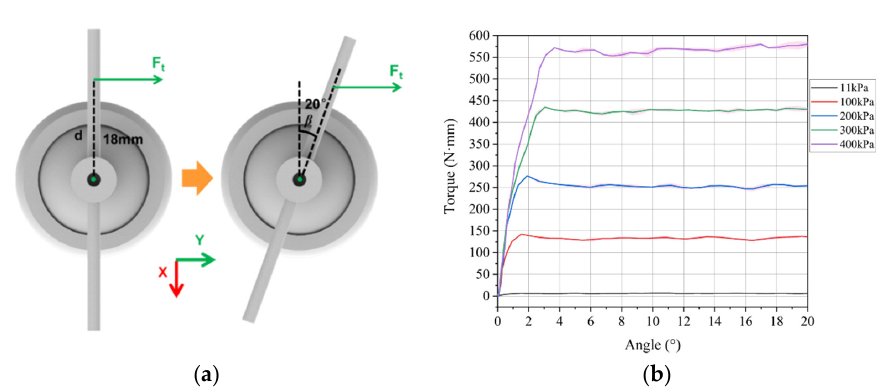
Figure 11. Experimental results of the twisting stiffness of the VSBJ at different input air pressures: ( a ) Schematic illustration of the point of application of the pulling force; ( b ) torque-angle curves at different air pressures.